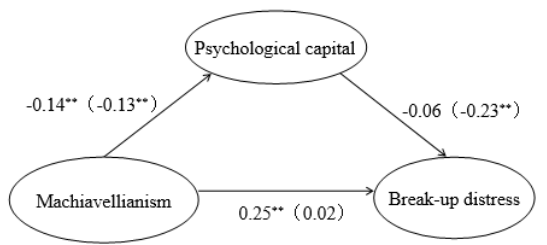
Figure 2. Gender differences in the mediating model (the coefficients outside the brackets were males while those inside the brackets were females). ** p <